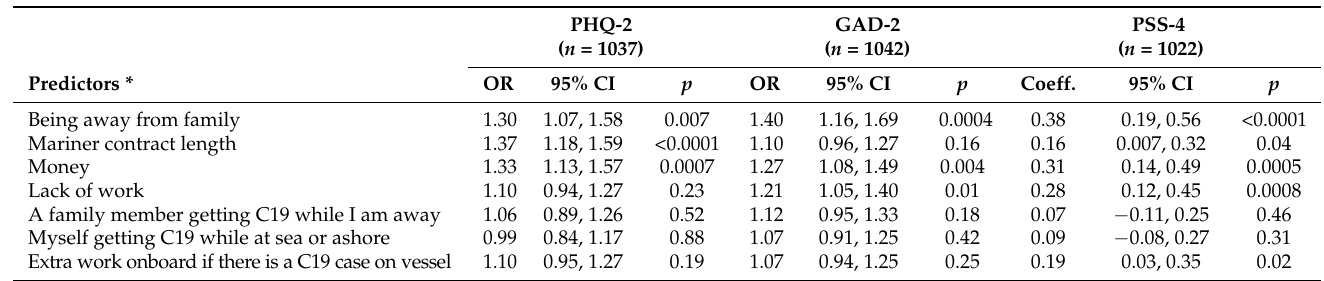
Table 5. Results of logistic and linear regression looking at frequency of COVID-19 concerns and outcomes of